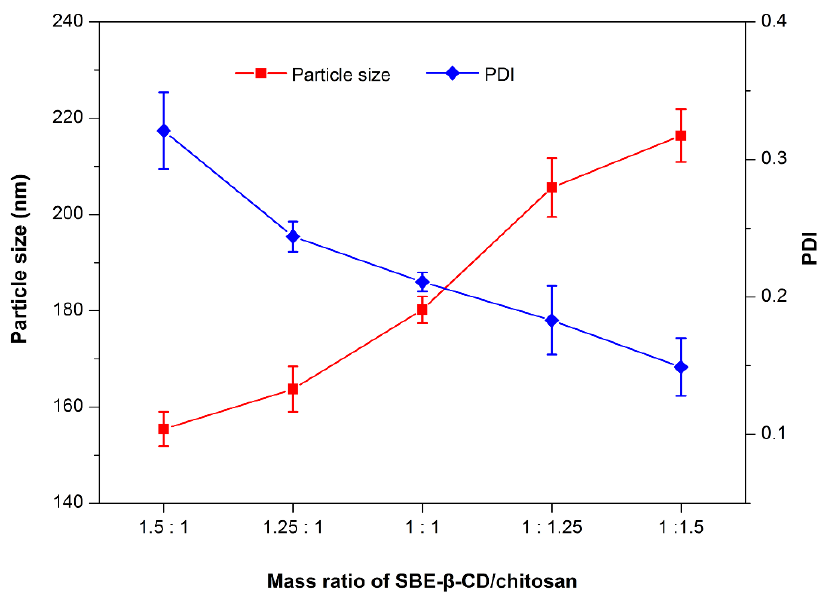
Figure 2. Effect of the mass ratio of sulfobutylether-β-cyclodextrin (SBE-β-CD)/chitosan in the formulation on particle size and PDI of raloxifene loaded cyclodextrin/chitosan nanoparticles (RXF-ccNPs).